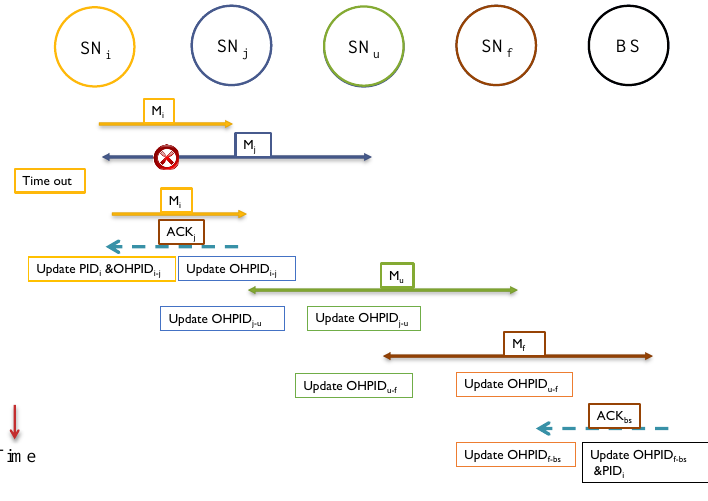
Figure 6. Handling lost